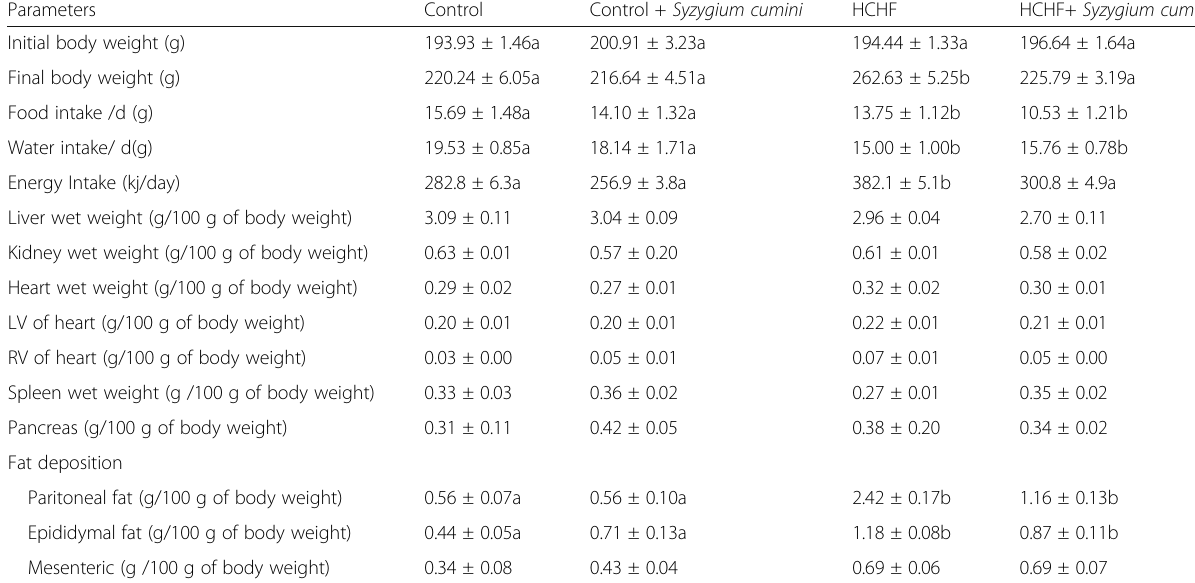
Table 3 Effects of HCHF diet and Syzygium cumini seed powder supplementation on body weight, food and water intake and organ wet weight of rats